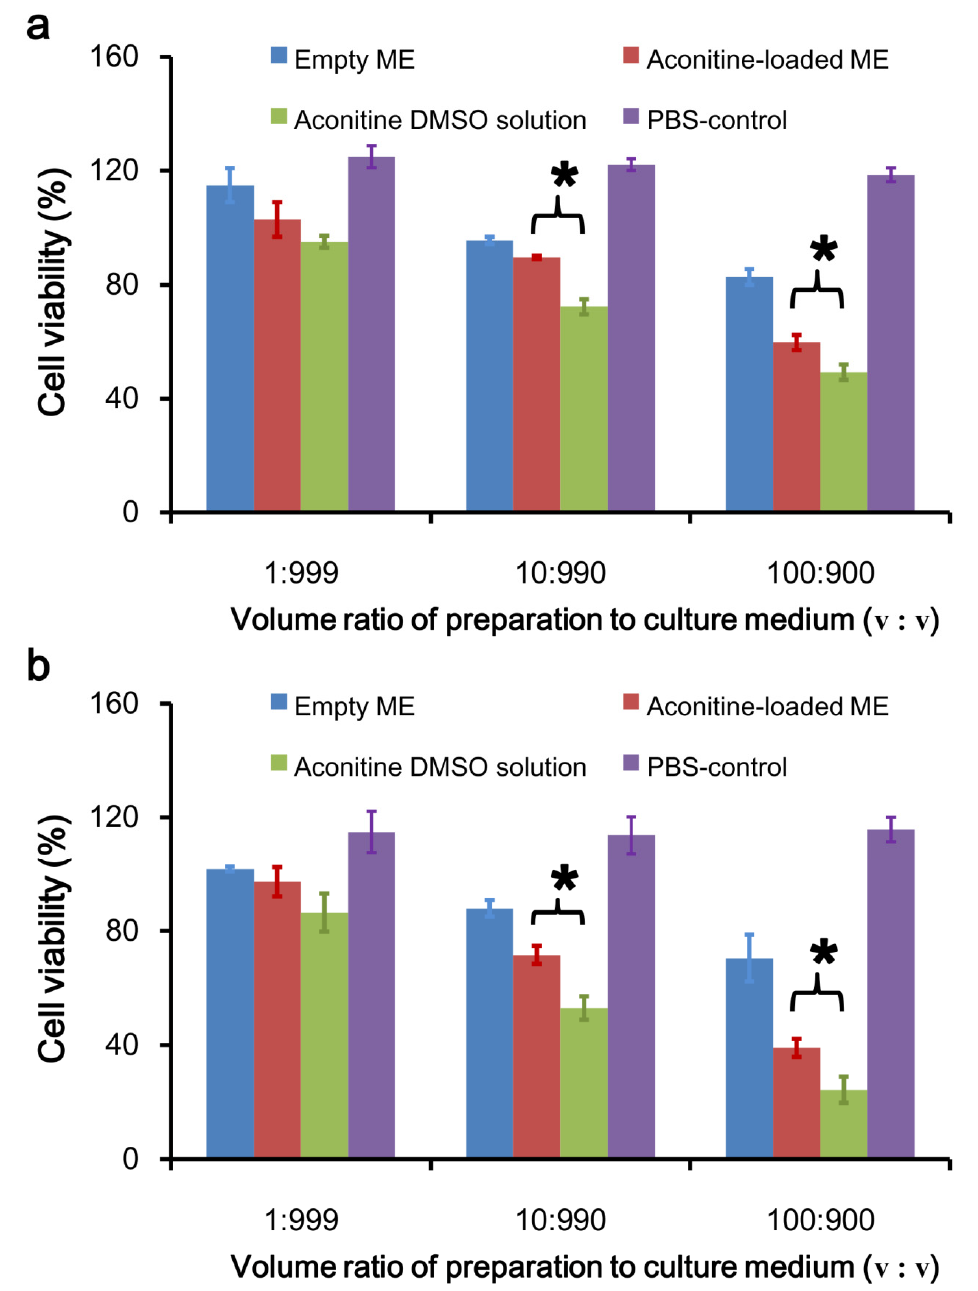
Figure 8. HaCaT ( a ) and CCC-ESF-1 ( b ) cell viability after being treated with various preparations for 24 h (ME, microemulsion; PBS-control, PBS without aconitine; * p < 0.05; n = 3). 3.6. Skin Irritation After 7 consecutive days of transdermal administration in vivo, normal skin and damaged skin showed no obvious irritant reaction, and the microstructure of the skin showed that the cell morphology of each layer was normal and no inflammatory reaction had occurred (Figure 9).